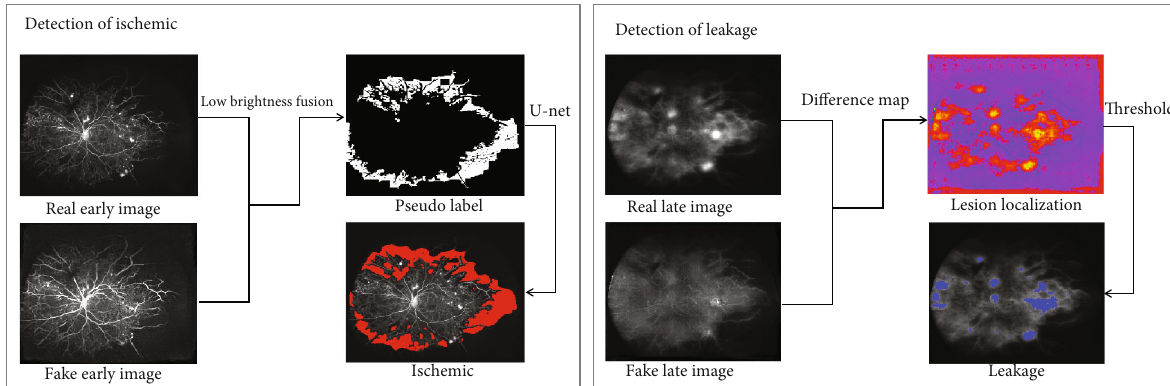
Figure 2: Detection of biomarkers. The low brightness biomarkers, i.e., nonperfusion areas on UWFA images, were obtained from the real image and the fake image by an automatic detection algorithm. A minimum fi lter extracts the local low brightness distribution of an image, which reveals the darker tissue or the nonperfusion area. The bright biomarkers, i.e., leakage and microaneurysms on UWFA images, are obtained from the results of localization and classi fi cation. The fake image is close to the normal image domain, where the abnormally bright areas are replaced by a lower brightness appearance. The di ff erence image of the real image and fake image reveals the anomaly detection of leakage. A thresholding operation leverages the anomaly map to the segmentation of leakage. The leakage index is the ratio of the leakage area to d 2 .